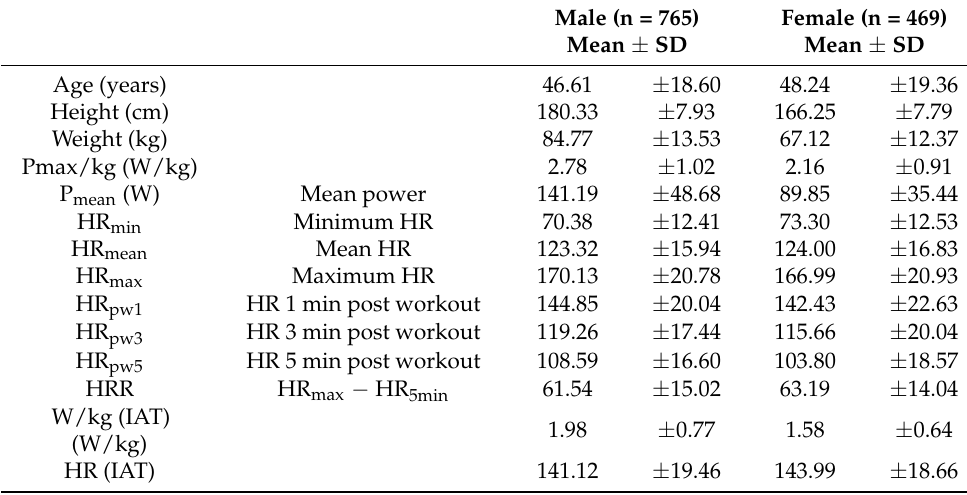
Table 1. Baseline characteristics of male and female subjects.